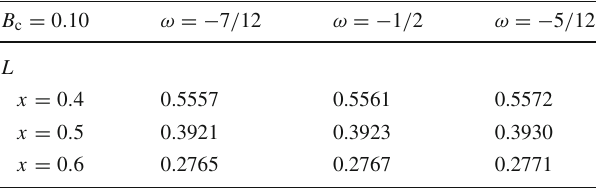
Table 1 The latent heat of the phase transition for different ω with B c = 0 . 10